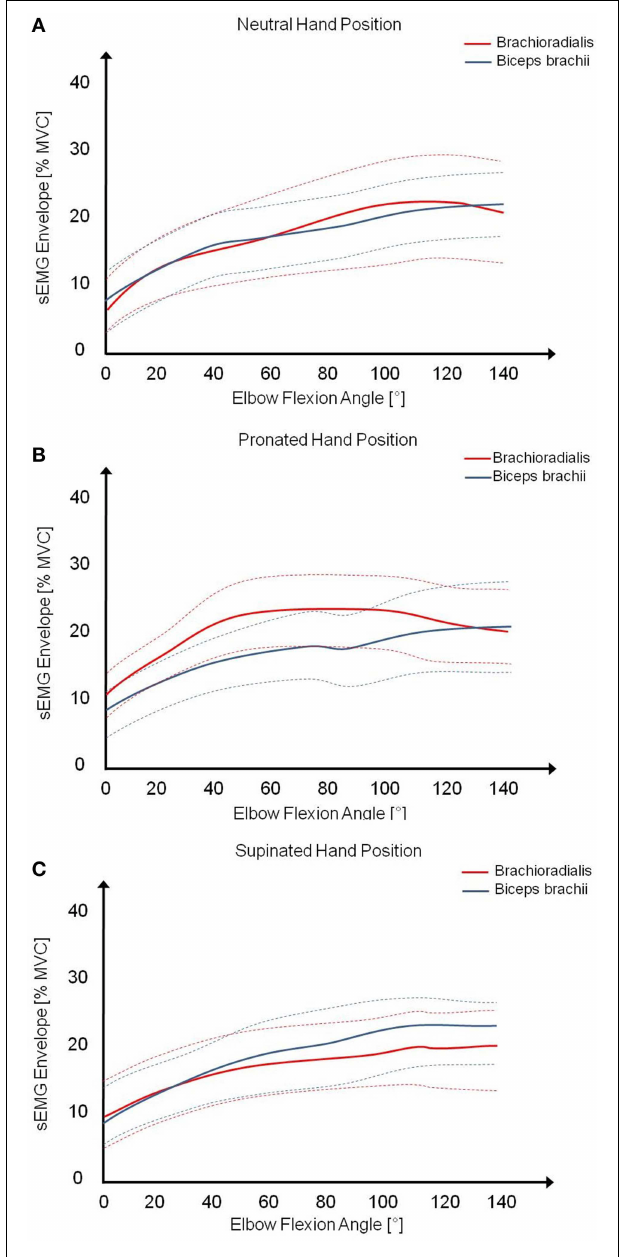
FIGURE 2 | Mean (solid lines) and standard deviation (dashed lines) of the muscular activity of biceps brachii and brachioradialis from all subjects during elbow flexion in (A) neutral, (B) pronated, and (C) supinated hand